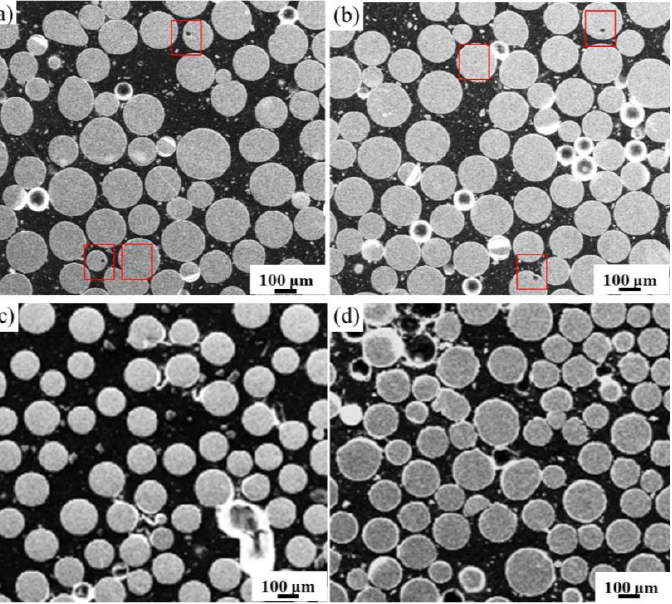
Figure 1. Cross-sectional morphology of Ti-6Al-4V alloy powders at ( a ) 8000; ( b ) 10,000; ( c ) 12,000 and ( d ) 14,000 RPM.